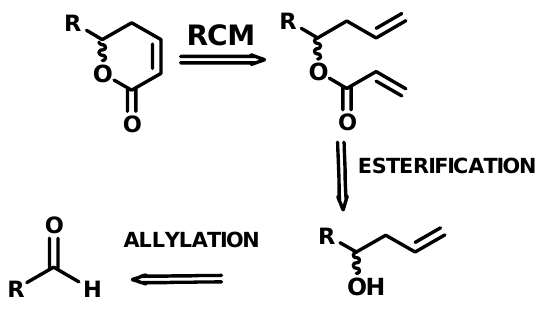
Figure 1. Retrosynthetic analysis of the lactone